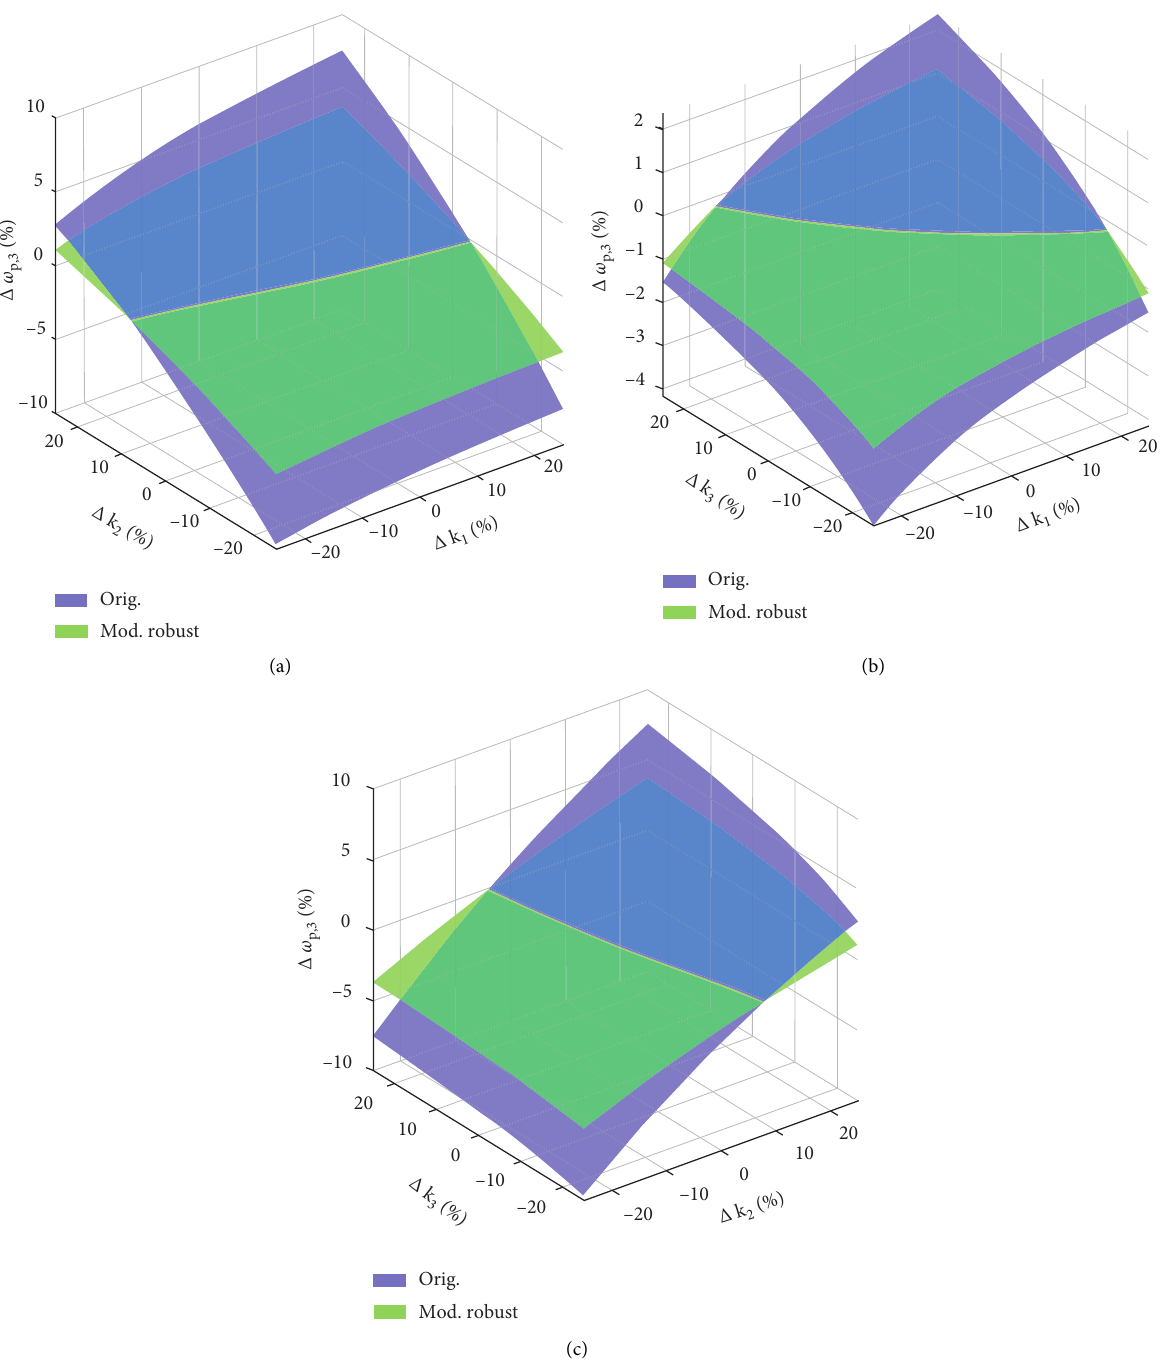
Figure 9: Test-case 3: percentage variation of the third natural frequency in the original and modified systems. (a) With fixed k fixed k 2 , and (c) with fixed k 1